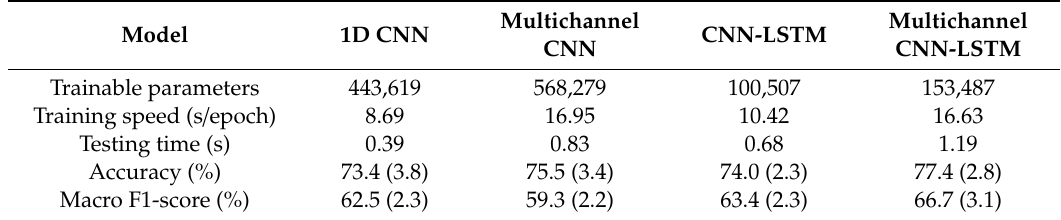
Table 2. Classification and computing performance of the deep learning models (averaged results for 10 runs with standard